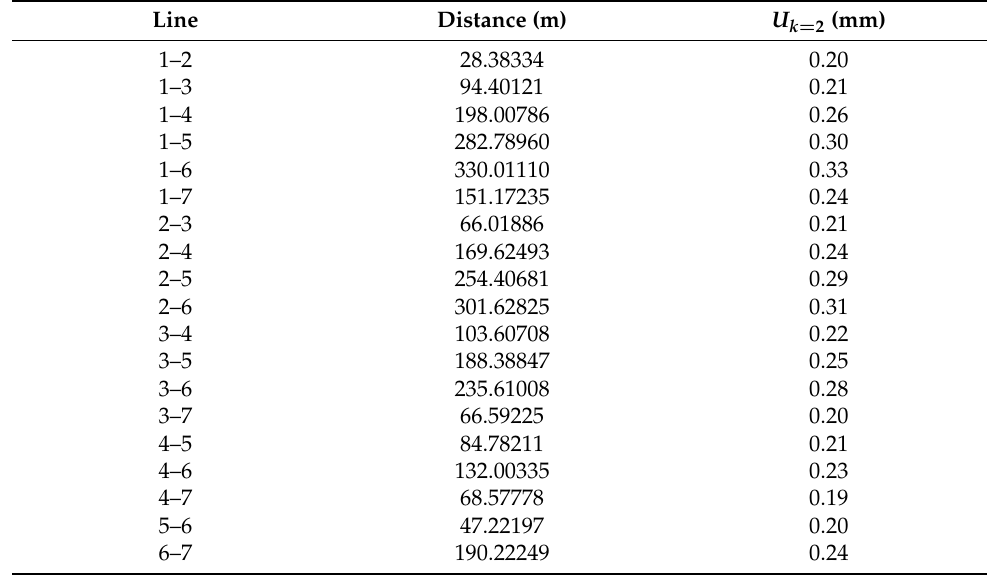
Table 2. Calibrated slant distances traced to SI-unit metre through the Nummela Standard Baseline and their expanded uncertainties U ( k =